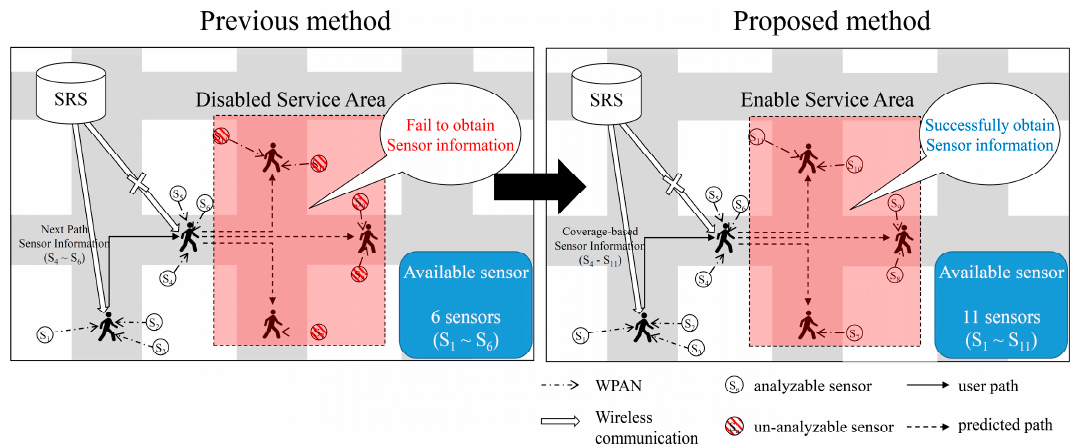
Figure 2. Network coverage information-based method overview.